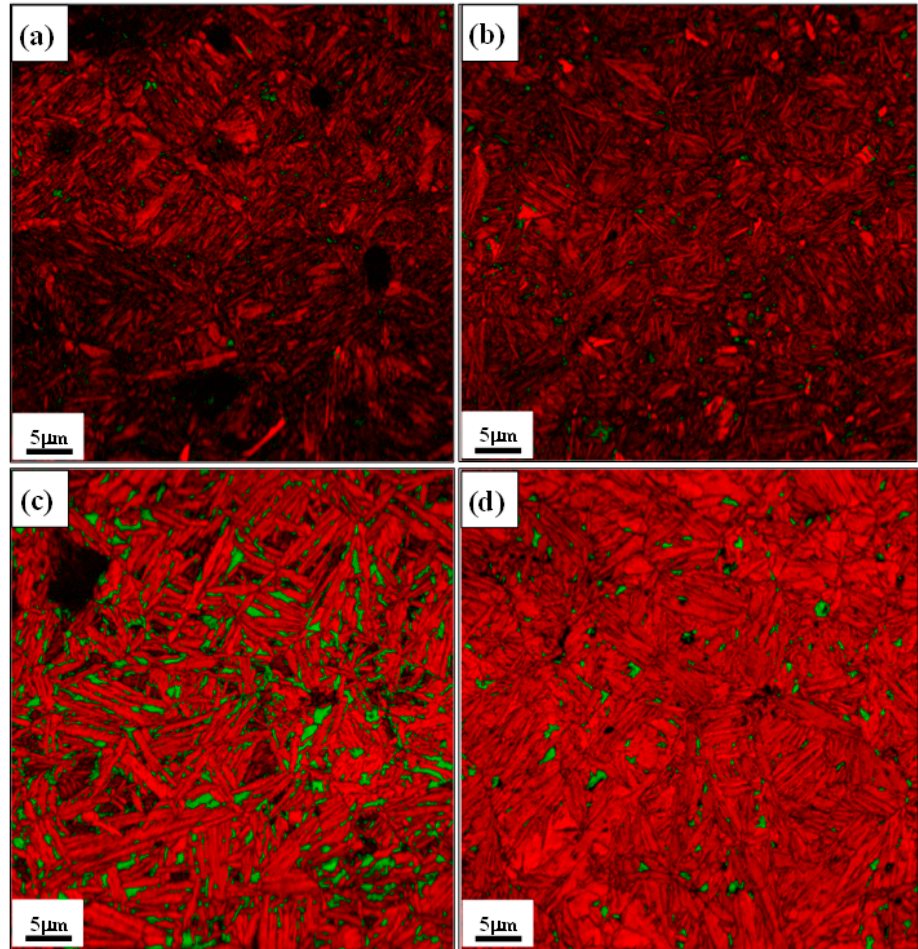
Figure 6. The combination of IQ and PMs electron images obtained by EBSD for the samples isothermally treated at 350 °C for: ( a ) 5 s; ( b ) 30 s; ( c ) 200 s; ( d ) 1 h; and then followed by subsequent water quenching. The green, black and bright red colored regions are retained austenite, martensite and bainitic ferrite microphases, respectively. Table 3. The variation in volume fractions of retained austenite taken from Q&B heat-treated samples determined by different analyzing methods.